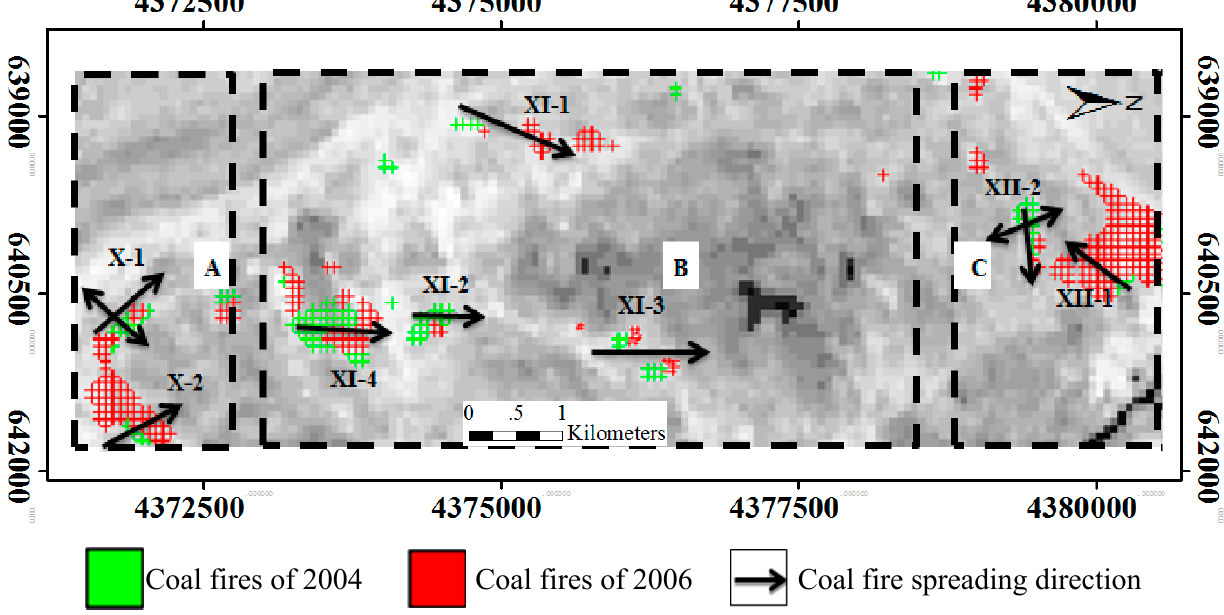
Figure 13. Coal fire map from 2004 to 2006. The results of the coal fires of 2004 and 2006 were stacked for the overlay analysis, and the coal fire spreading directions were also delineated as shown in this